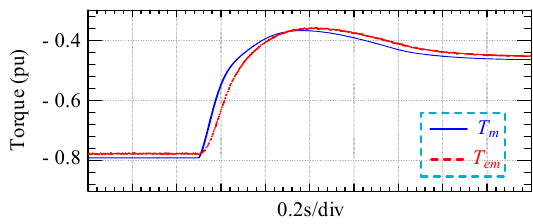
Figure 19. Mechanical and electromagnetic torques of DFIG-WT.